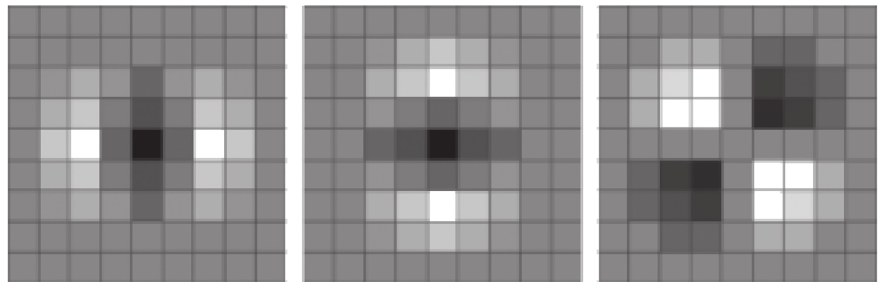
Figure 3: The second order Gaussian derivative in different direction.